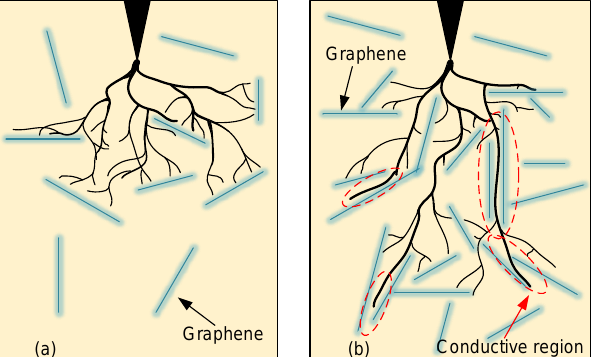
Figure 11. Effect of graphene nanoplatelets in the treeing process; ( a ) Inhibition effect of graphene and the formation of the bush tree; ( b ) Conductive regions at high graphene contents and their acceleration effect on tree growth.